Question: In one sentence, what is this figure communicating?
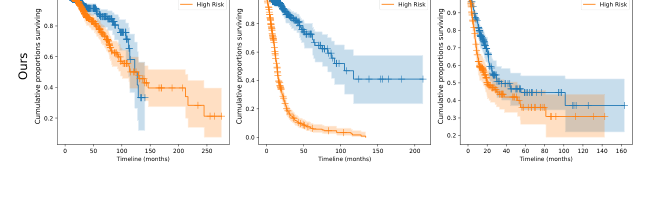
Answer: Kaplan-Meier Analysis on three datasets, where patient stratifications of low risk (blue) and high risk (orange) are presented. Shaded areas refer to the confidence intervals. P-value < 0.05 means the significant statistical difference in two groups, and the lower P-value is better.